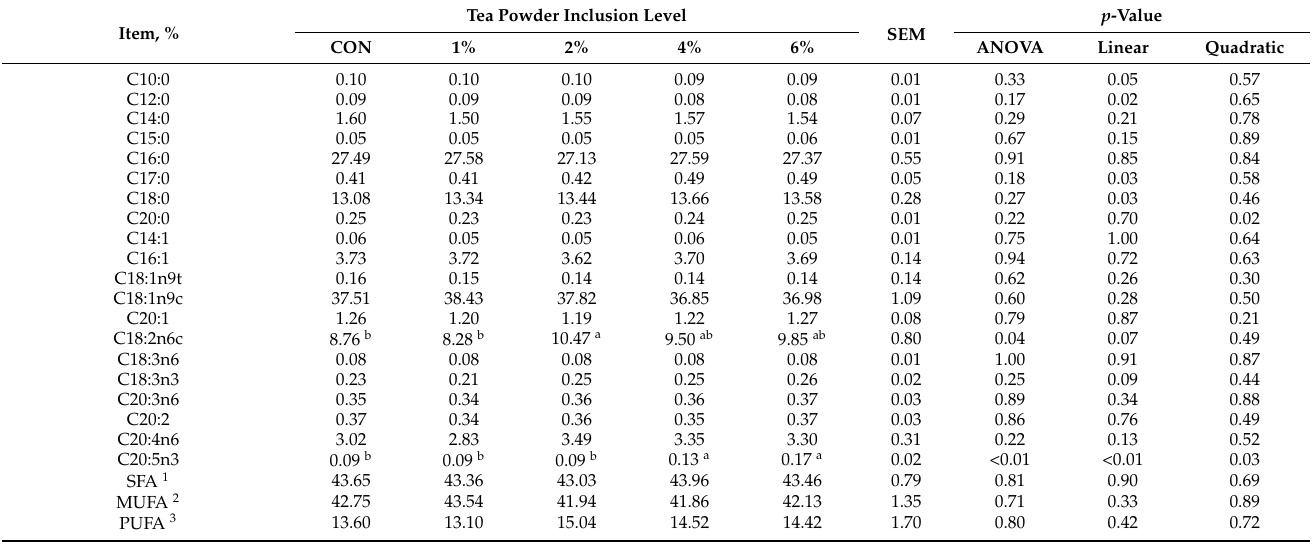
Table 8. Effects of dietary tea powder on fatty acids profile of LD muscle tissue of the